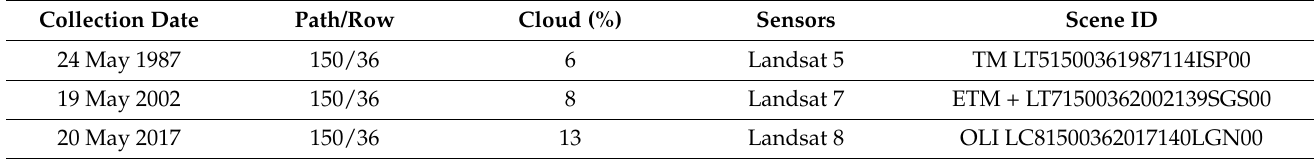
Table 1. Source origin of downloaded images(United States Geological